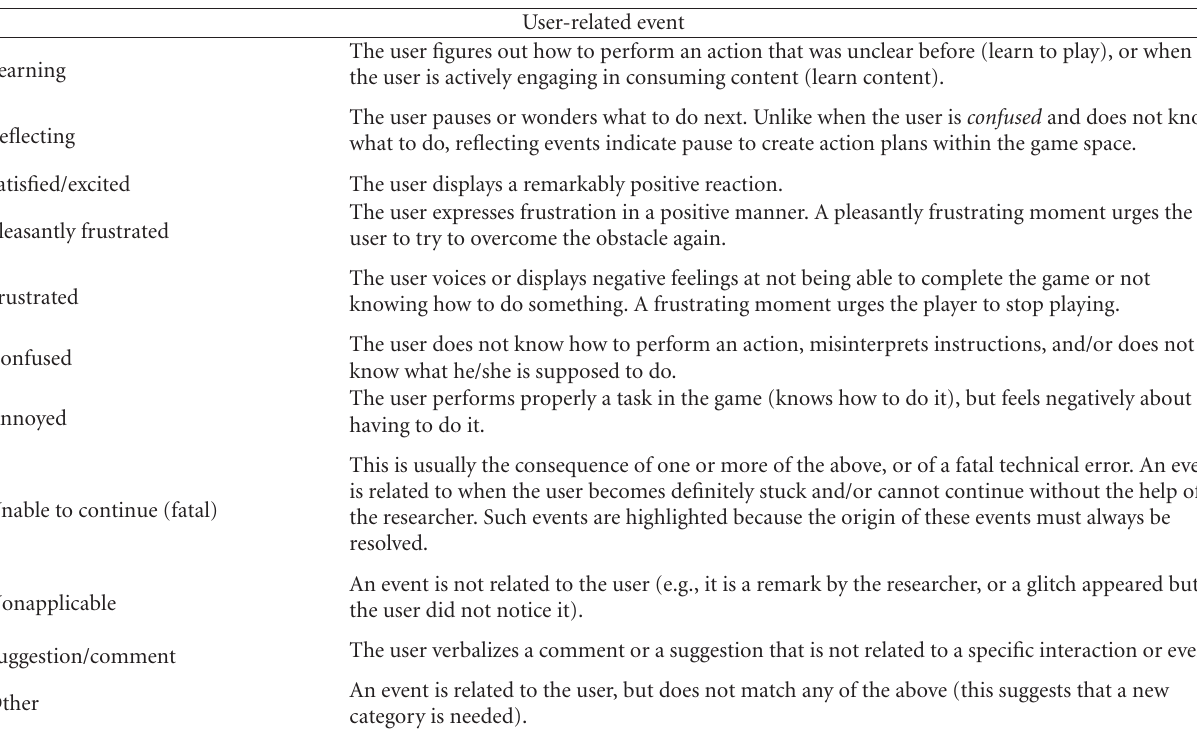
Table 2: Event categories for the user